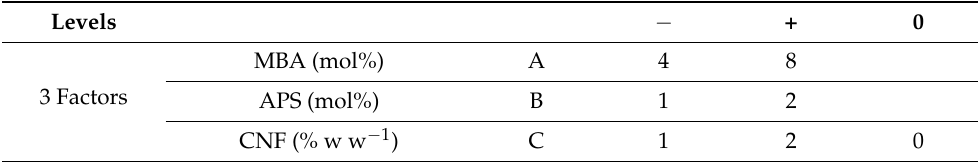
Table 1. Factors to be studied and their respective levels, where − , +, and 0 indicate the minimum, maximum, and control levels respectively.